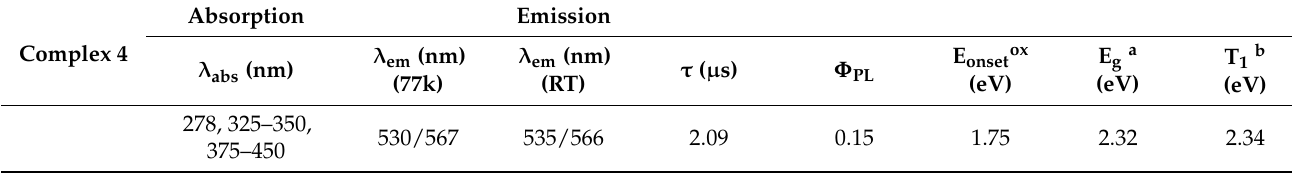
Figure 2. ( a ) Absorption spectrum of 4 in dichloromethane (green line) and the emission spectrum of 4 in solid state (red line); ( b ) emission spectra of 4 at different concentrations in dichloromethane at room temperature, inset: the photograph of 4 in dichloromethane excited at 365 nm (1.0 × 10 − 3 M); ( c ) emission spectra of 4 in different solvents at the concentration of 1.0 × 10 − 5 M, ( d ) the low temperature emission spectrum of 4 at 77 K in 2−MeTHF. Table 1. Photophysical data of complex 4 at concentrations of 1.0 × 10 − 5 M were studied using cyclic voltammetry (Figure S6). The